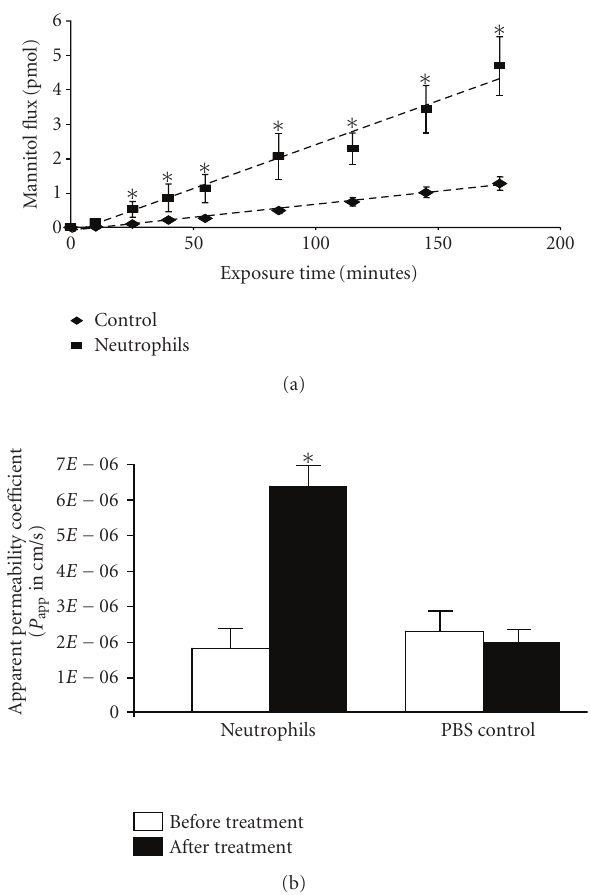
Figure 1: Neutrophil exposure increased explant permeability. (a) The kinetics of RPE explant permeability following neutrophil treatment. The basolateral side of the explant was incubated with neutrophils for 1 to 3 hours at 37 ◦ C. (b) Neutrophil-induced increase of permeability of the RPE explant. The basolateral side of the explant was incubated with neutrophils for 3 hours at 37 ◦ C. The apparent permeability was determined by [ 3 H]-mannitol flux. The increased permeability induced by neutrophils is significant compared with control. ∗ represents P < . 05. Addition of PBS to the explant did not change the